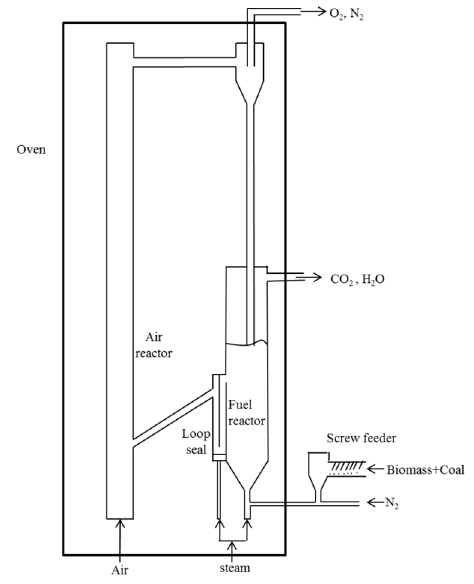
Figure 1. Experimental setup [23].